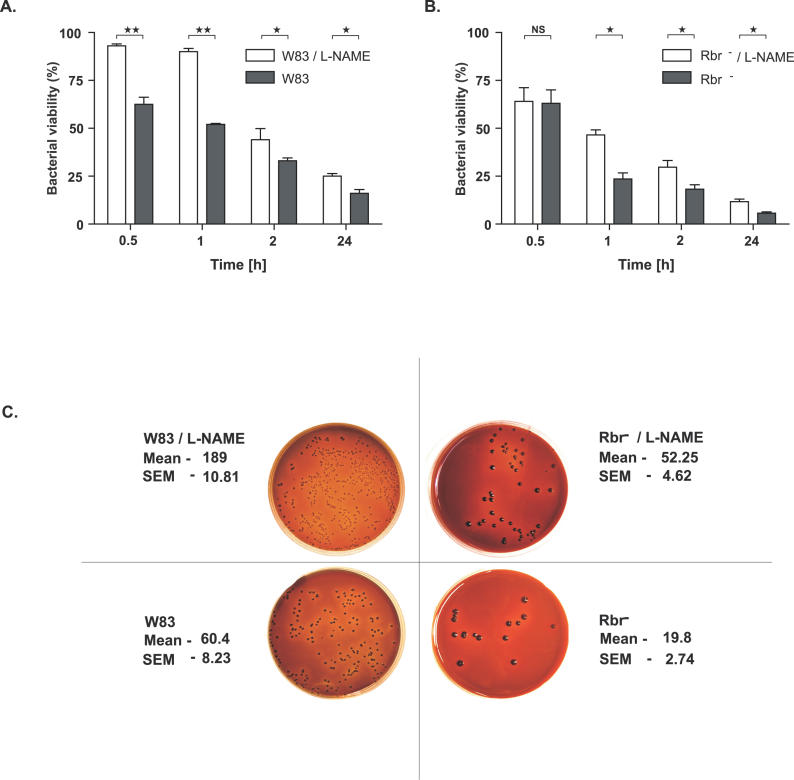

P. gingivalis Killing by Murine Macrophages in the Presence and Absence of Nitric OxideMurine macrophages were incubated with opsonized P. gingivalis (the wild-type or Rbr− strain) at a ratio of 1:10 in the presence or absence of iNOS inhibitor (L-NAME). At the indicated timepoints, samples were withdrawn and plated, and the numbers of bacteria were determined. The CFU value at time zero was taken as 100%.(A) Wild-type P. gingivalis incubated with macrophages in the presence or absence of L-NAME. (B) Rbr− strain incubated with macrophages in the presence or absence of L-NAME.(C) Representative pictures of P. gingivalis W83 (left panel) and Rbr− (right panel) colonies from the 24-h timepoint grown on anaerobic blood agar plates.In (A) and (B), statistical significance of the differences in the CFU values was calculated using the Mann-Whitney U test (*p < 0.05; **p < 0.01).